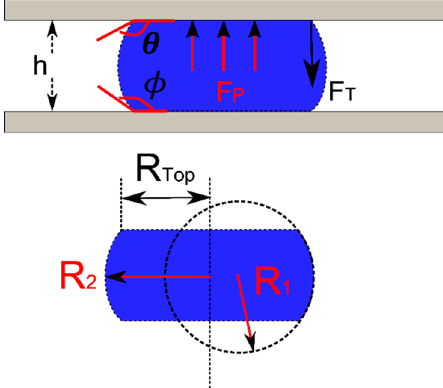
Figure 2. Capillary bridge between two parallel surfaces. When the top and bottom contact angles ( θ and Φ ) are greater than 90°, the pressure force ( F p ) pushes the top plate upwards and the surface tension force ( F T ) acts downwards to pull the plates together. The two principle radii of curvature ( R 1 and R 2 ) can be are used to calculate the pressure difference across the interface and R Top is the contact radius of the droplet to the top plate.